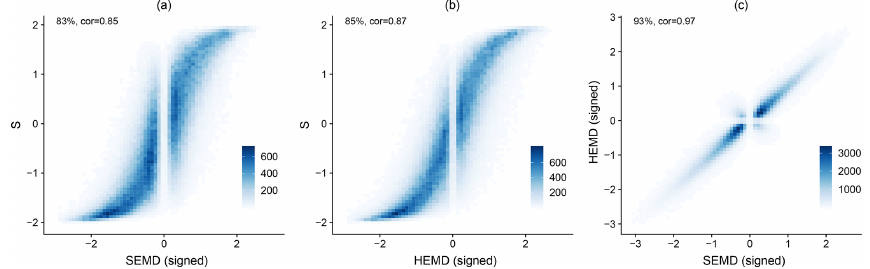
Figure 12. Bi-variate histograms of SEMD and S (a) , HEMD and S (b) , and SEMD and HEMD (c) . The two wavelet scores have been endowed with the sign of the corresponding difference in centre. Percentages indicate the fraction of cases where the two scores have the same sign; cor denotes the correlation.